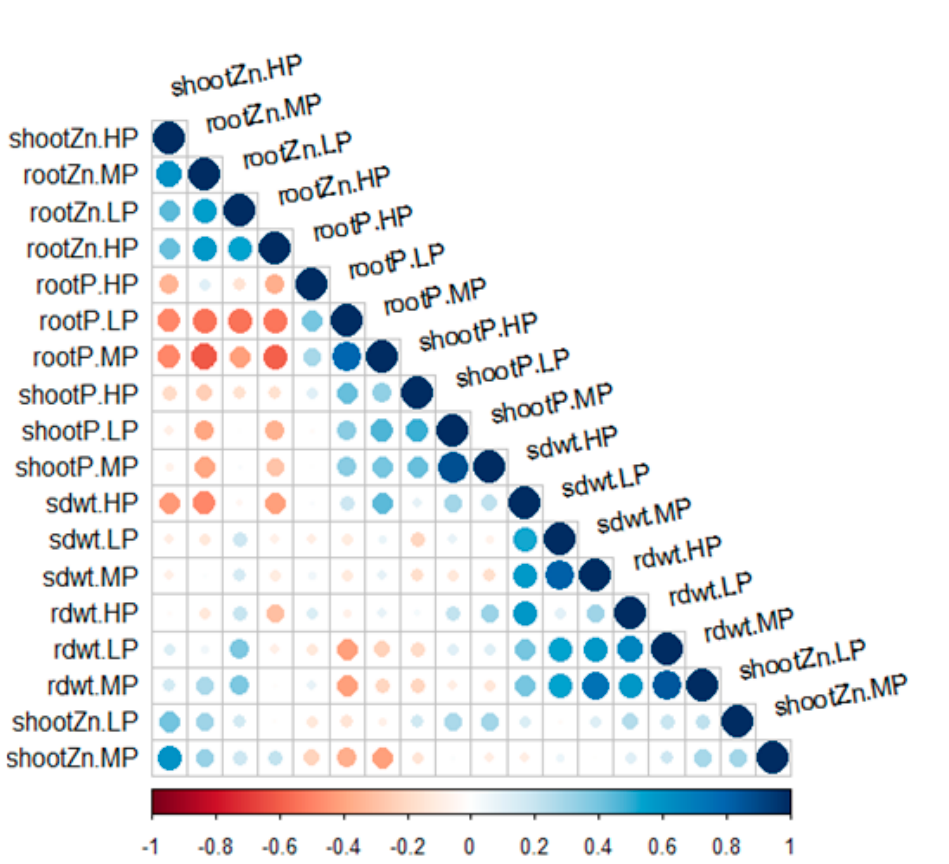
Figure 4. Correlation matrices for traits measured across varying soil phosphorus levels in the screenhouse (n = 30 genotypes). Positive and negative associations between given traits are in blue and red, respectively. The color intensity and the size of the circle are proportional to the correlation coefficients. On the X -axis of the correlogram, the legend color shows the correlation coefficients and the corresponding colors. LP = low phosphorus (no-P application), MP = medium phosphorus (1.5 mg P kg − 1 ), and HP = high phosphorus (30 mg P kg − 1 ). See Table 1 for list and abbreviations of the traits.